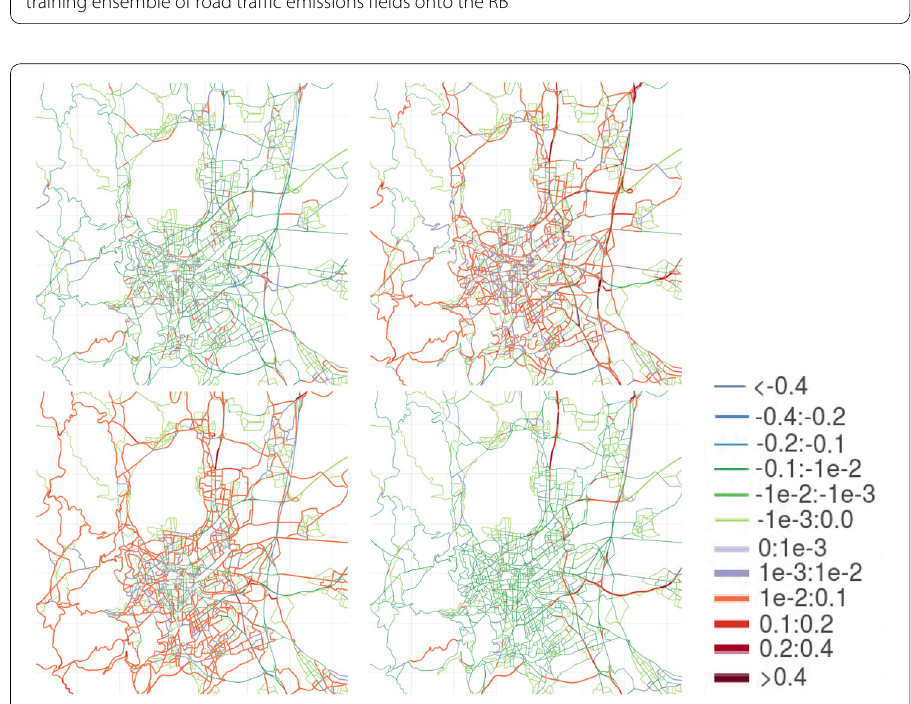
Fig. 3 Left: Singular values of the emissions mass matrix. Right: L 2 relative mean projection errors of the LHS training ensemble of road traffic emissions fields onto the